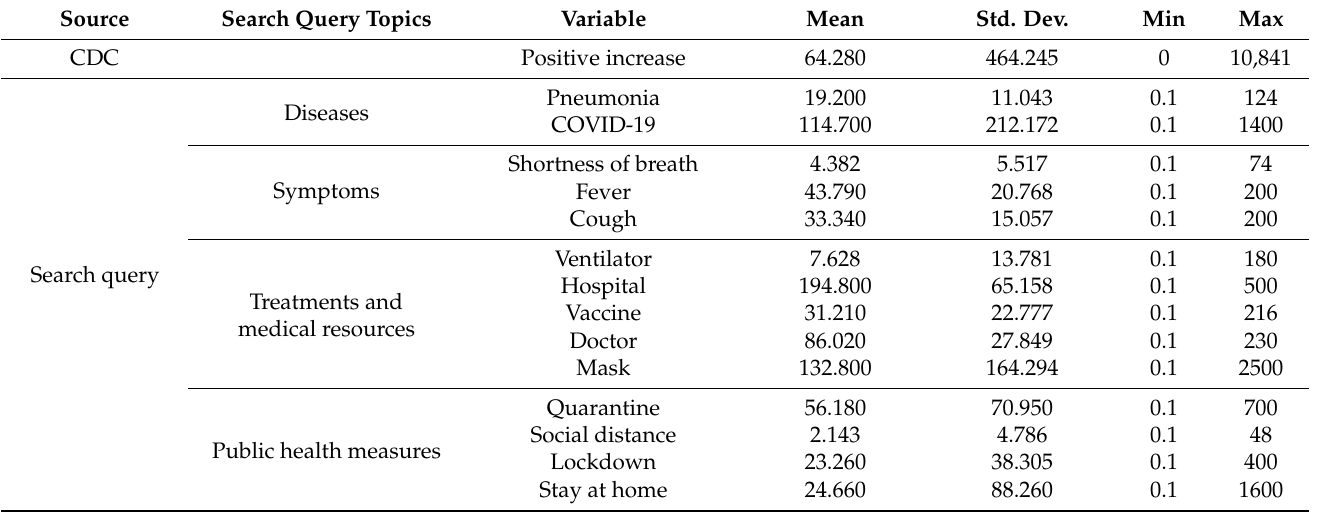
Table 1. Descriptive statistics of the main variables.